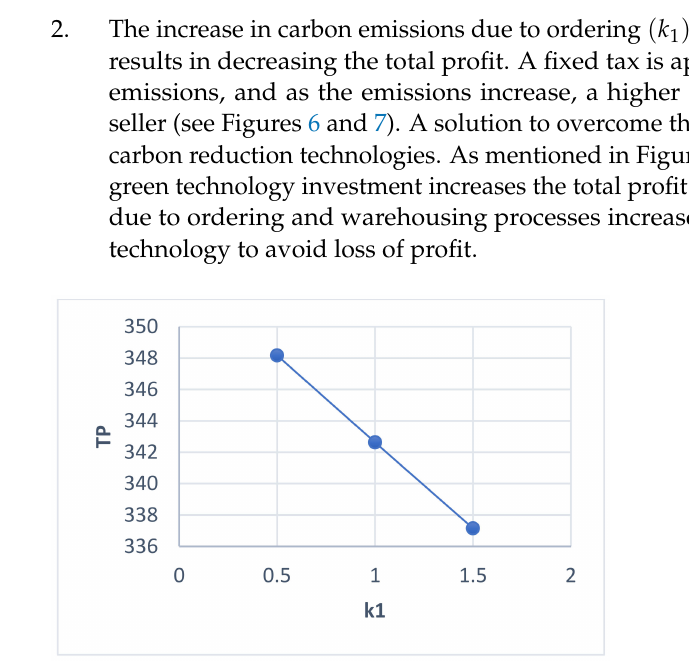
Figure 6. Impact of increasing k 1 on total profit.